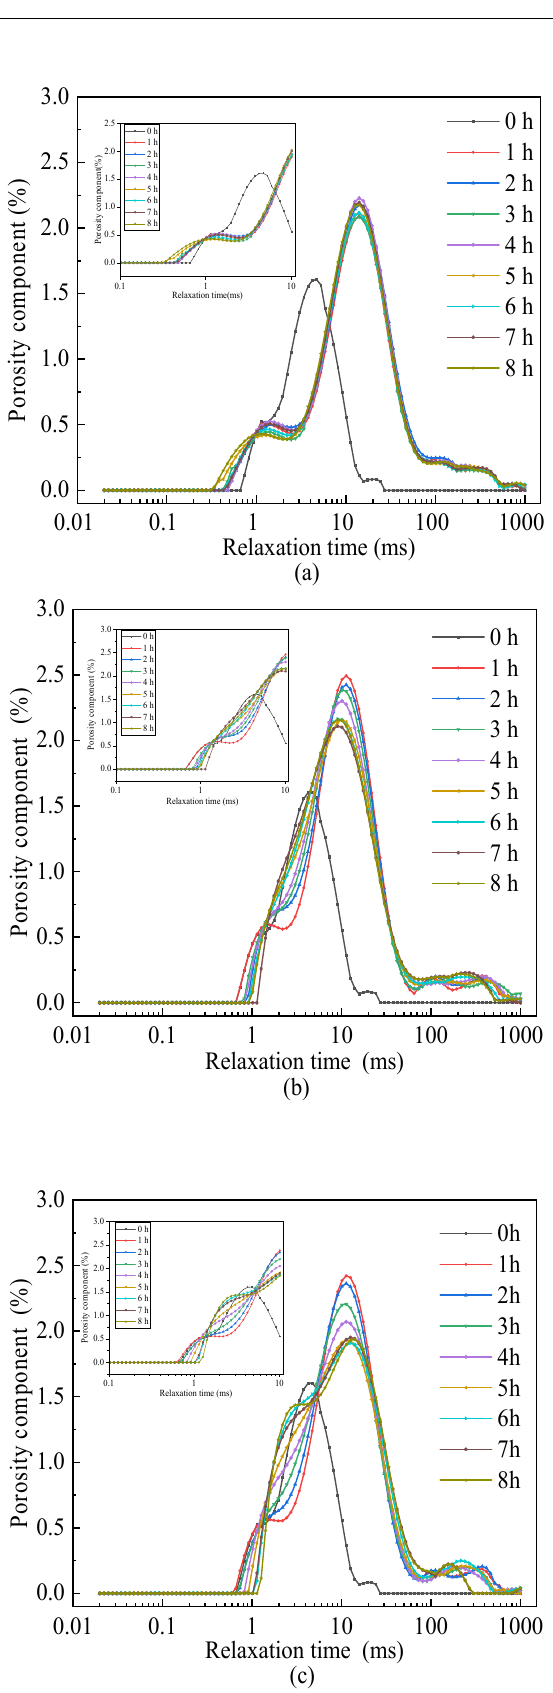
Figure 8. Variation of T 2 distribution curves of specimens in different concentrations of MgSO 4 and DI water leaching solution with leaching time. ( a ) DI water; ( b ) 2% MgSO 4 ; ( c ) 5% MgSO 4 . The pore radius in microns ( μ m) refers to the maximum radius of the sphere that can pass through the pore throat. The size and percentage distribution of the pore radii are closely related to the pore structure. The larger the pore radius, the better the connectivity of the pore space. Pore radii of different sizes as a percentage of the total pore reflect the pore radius distribution in different leaching time periods. According to the range of